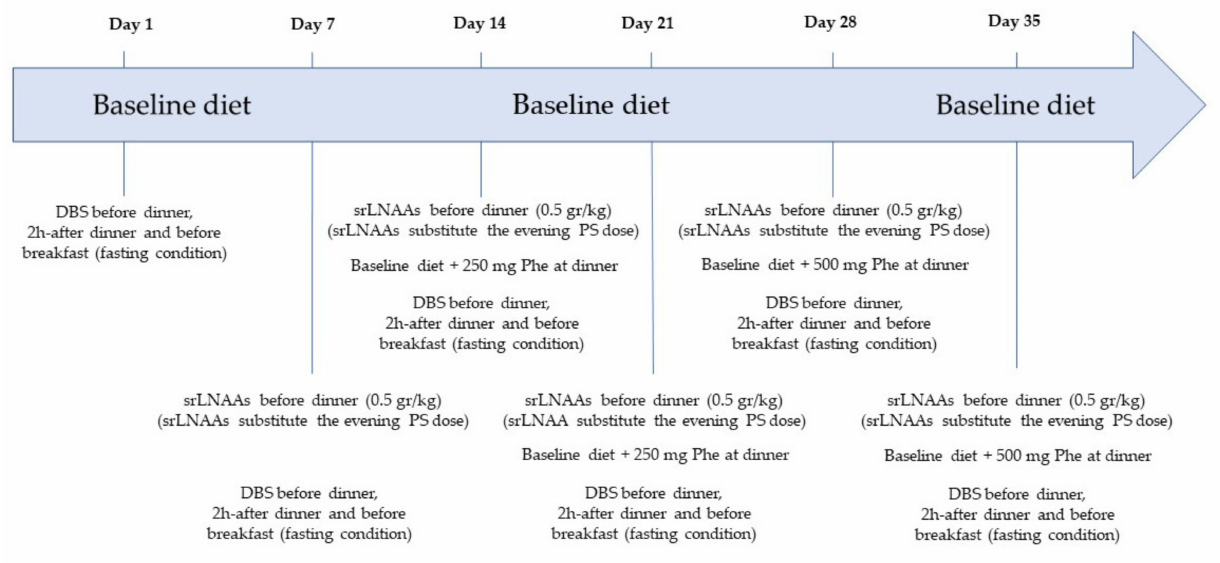
Figure 1. Study protocol.